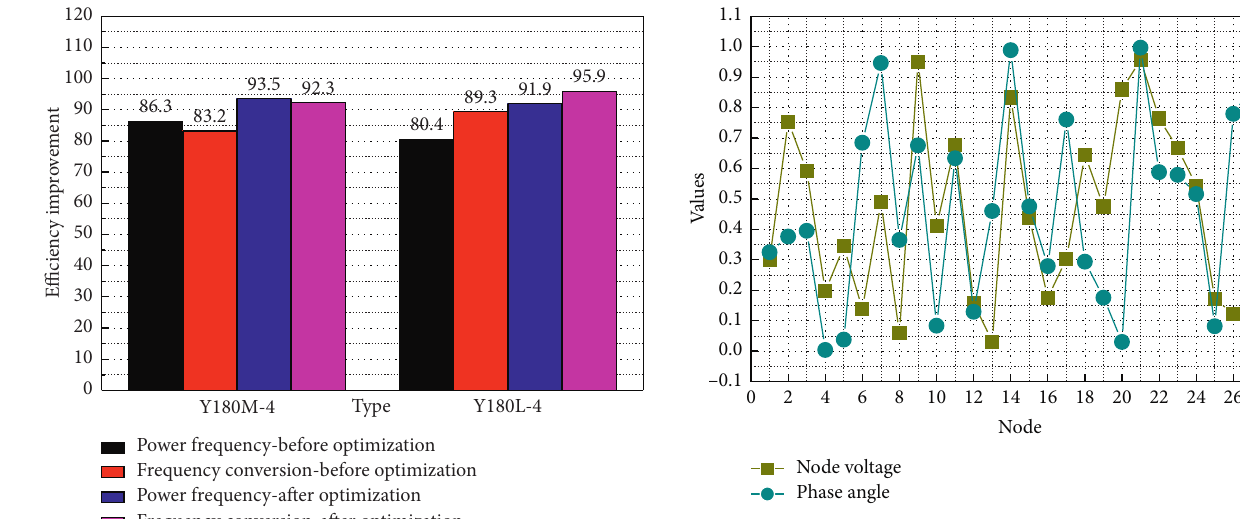
Figure 8: Calculation results of the original state tide at each